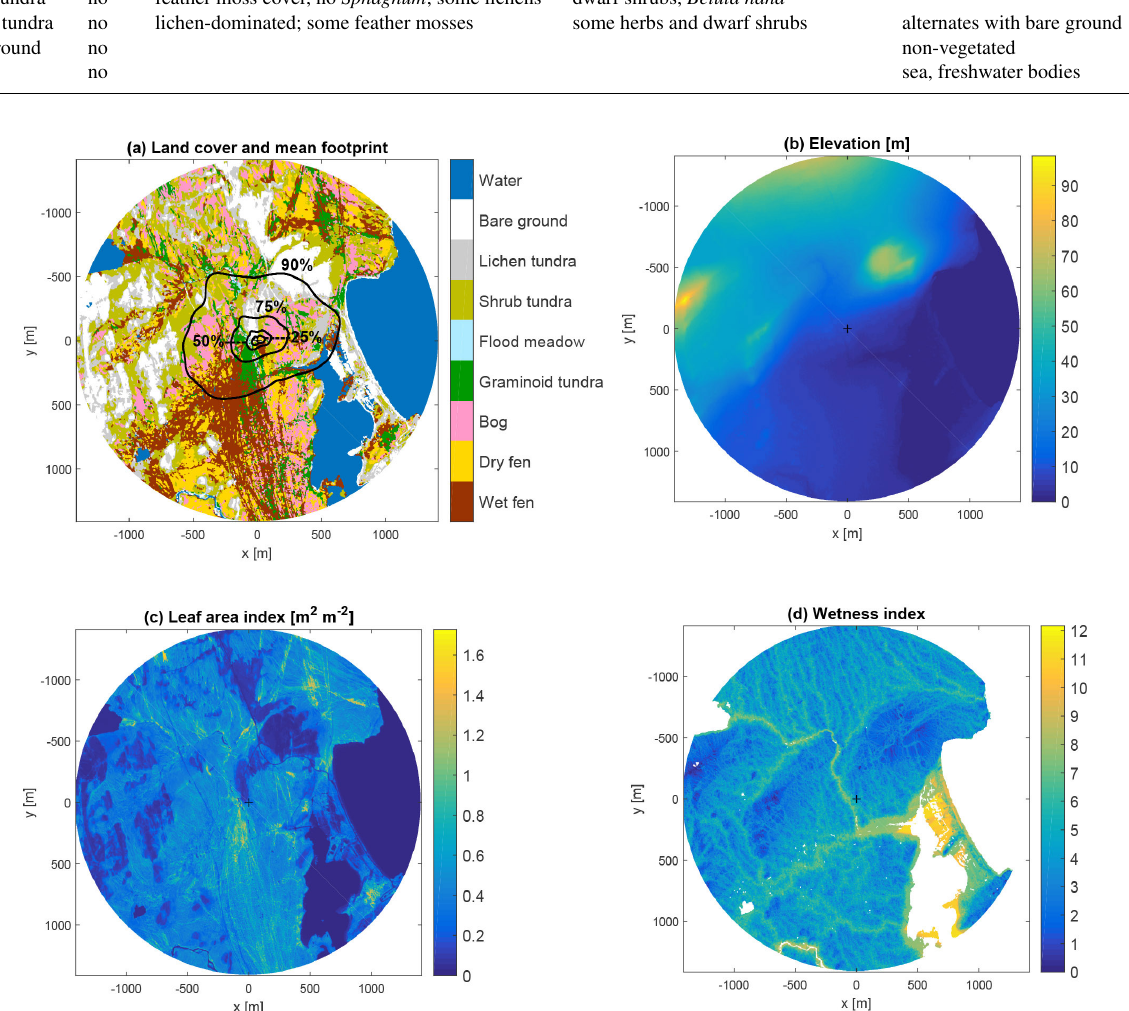
Figure 1. Land cover classes and the mean cumulative footprint during the growing season of 2014 (a) , terrain elevation (b) , maximum leaf area index (on 12 August 2012) (c) and topographic wetness index for terrestrial surfaces (d) . The isopleths in panel (a) indicate the areas with a 25%, 50%, 75% and 90% contribution to the measured flux (only the further distance visible). The plus sign indicates the location of the EC